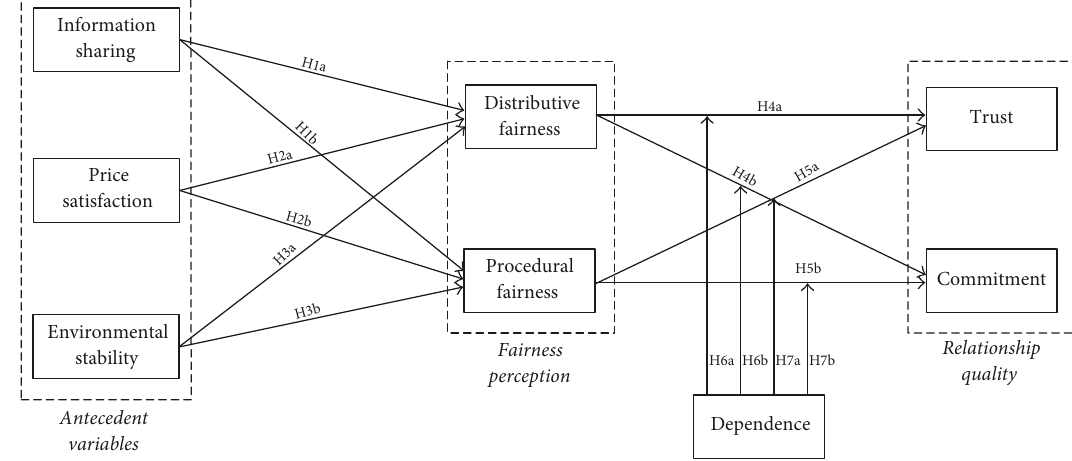
Figure 1: A theory model of supplier-retailer relationship